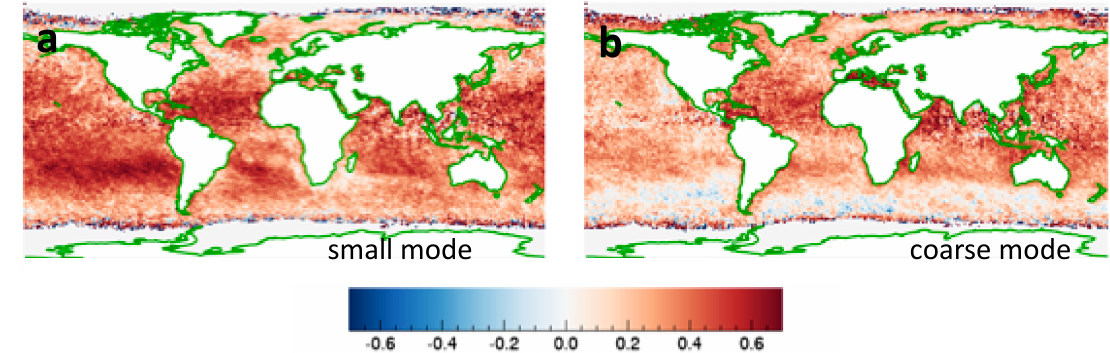
Figure 12. Map of relationships between CF and aerosol optical depth (AOD) separately for small- and coarse-mode aerosols. CF-AOD correlations for ( a ) fine mode and ( b ) coarse mode. The figure is based on Figure 5 of [42].